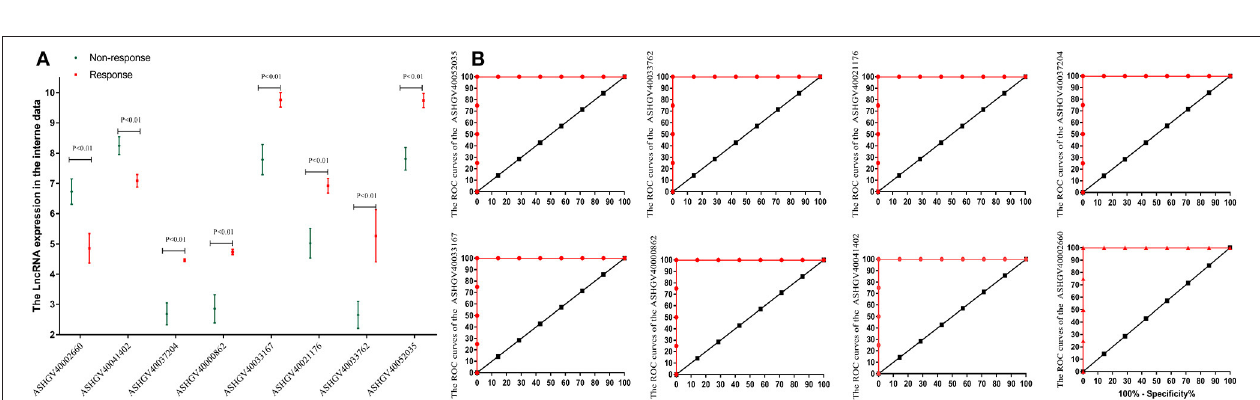
FIGURE 3 | Weighted correlation network analysis (WGCNA) and hub gene screened. (A) Dendrogram of all expressed genes in the top 25% of variance clustered based on a dissimilarity measure (1 – TOM). (B) The mechanism of the hub long non-coding RNAs (lncRNAs). (C) Heatmap of the correlation between module eigengenes and chemotherapy resistance. (D) Scatter plot of the correlation between the black module and chemotherapy resistance. (E) Gee Ontology (GO) functional analysis of the top 10 pathways of genes in the black modules. (F) Kyoto Encyclopedia of Genes and Genomes (KEGG) pathway analysis of the top 10 pathways of genes in the black modules.